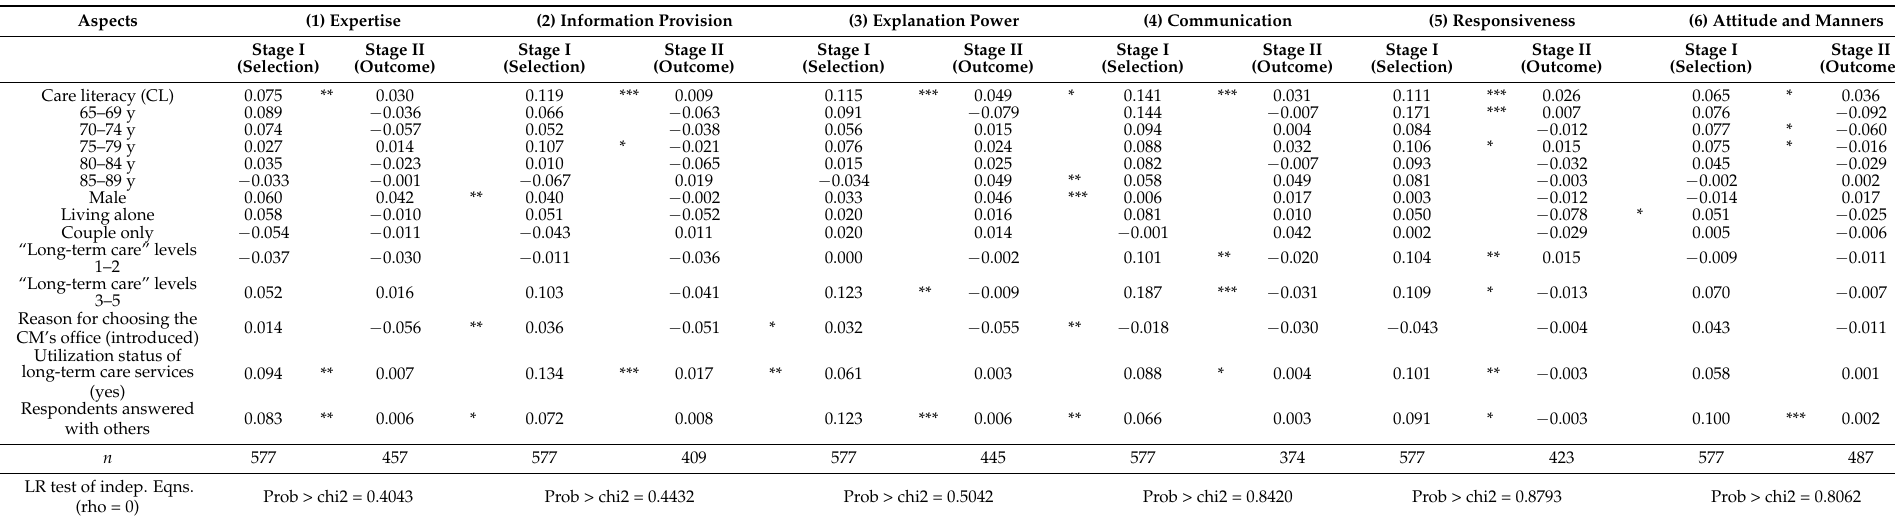
Table 6. Marginal effects of CL and other covariates on satisfaction with CMs estimated by Heckman probit